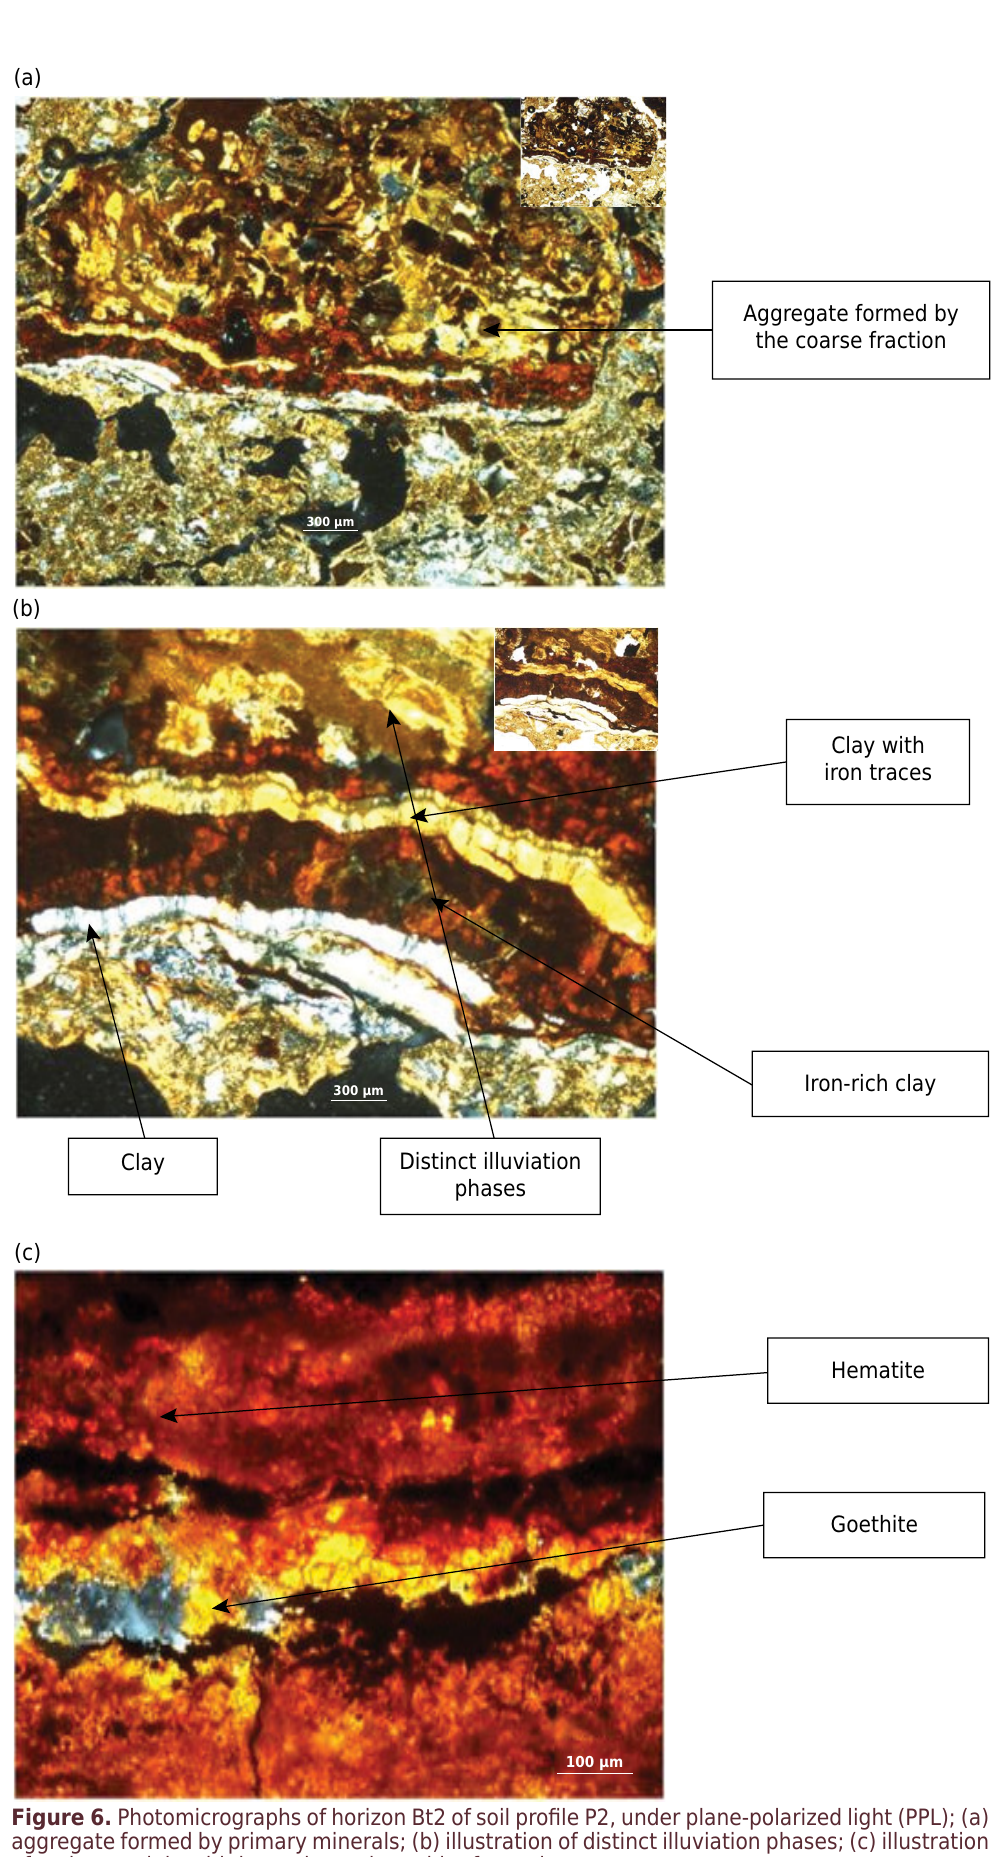
Figure 6. Photomicrographs of horizon Bt2 of soil profile P2, under plane-polarized light (PPL); (a) aggregate formed by primary minerals; (b) illustration of distinct illuviation phases; (c) illustration of an iron nodule with hematite and goethite